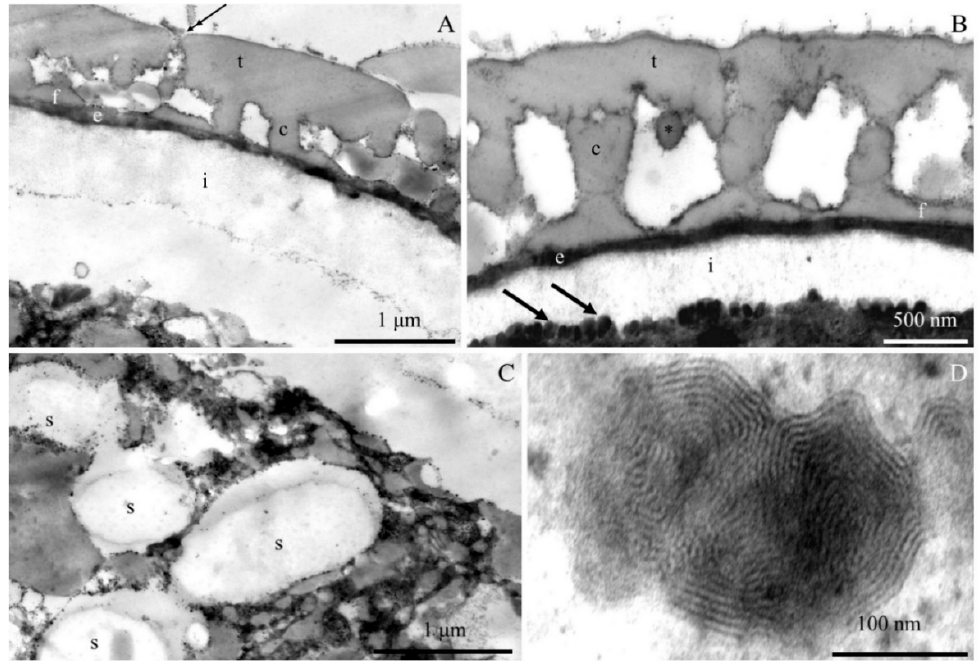
Figure 7. ( A – D ). Fragments of pollen grains in R. idaeus ‘Glen Ample’: ( A , B )—tectum (t), perforations (double-headed arrow), pollenkitt (asterisk), columellae (c), foot layer (f), endoexine (e), intine (i), numerous electron-dense structures (arrows) indicated by arrows in photo. B; ( C )—protoplast with electron-dense cytoplasm, starch grains (s) in amyloplasts; ( D )—characteristic concentric arrangement of electron-dense structures marked with arrows in phot. B. A – D - TEM.